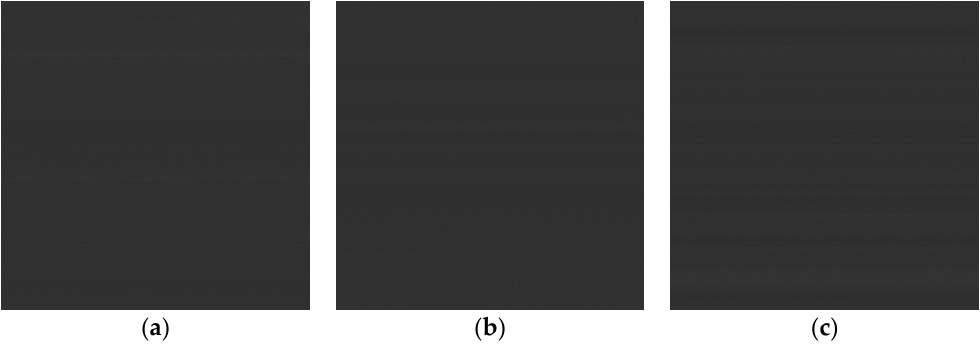
Figure 13. Correction result image of the evaluation image of Figure 10a with the modulated ‐ mode output of various ICS radiation. ( a ) modulated ‐ mode ICS ‐ 1000; ( b ) modulated ‐ mode ICS ‐ 3000; ( c ) modulated ‐ mode ICS ‐ 5000.